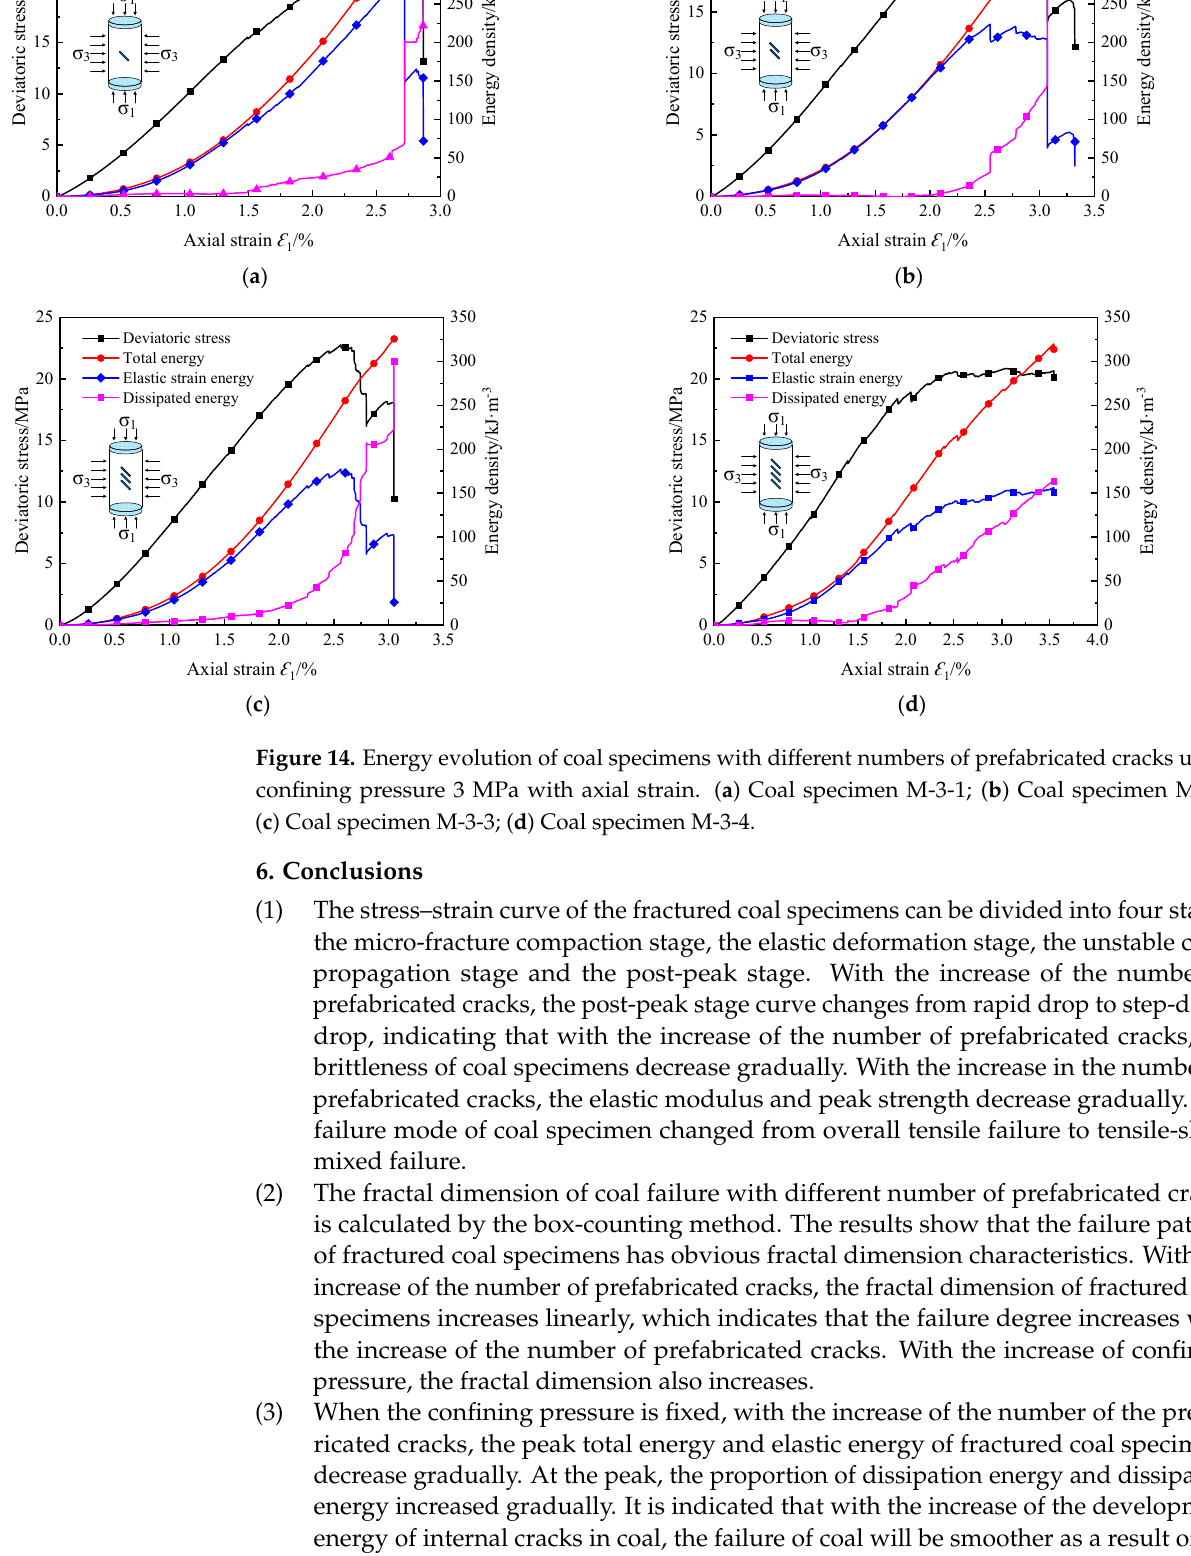
Table 2. Energy statistics at peak point of prefabricated cracked coal specimen.